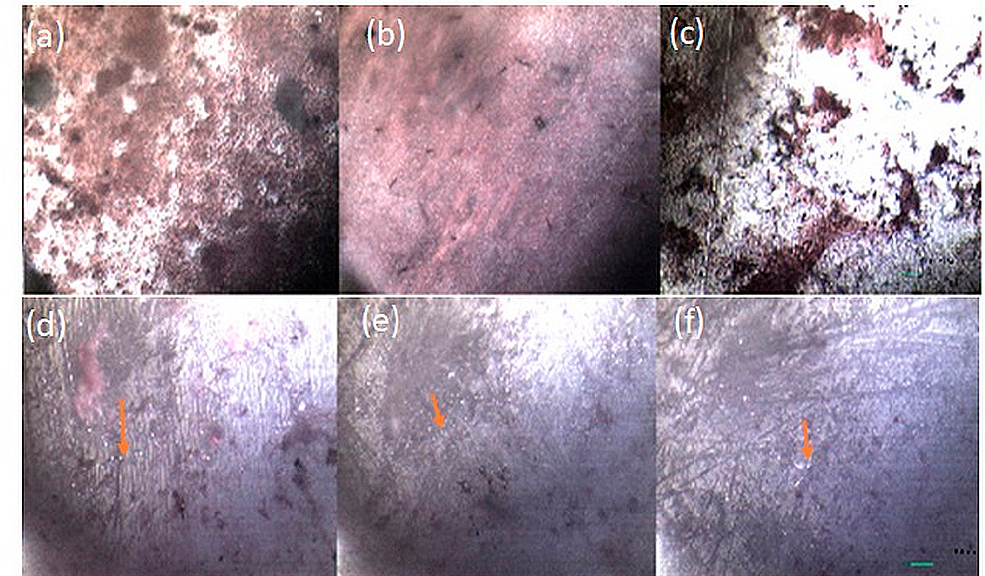
Figure 6. Optical microscopic images of Zn–HA discs at ( a ) 30 min, ( b ) 2 h and ( c ) 6 h and Zn–HA-coated samples at ( d ) 30 min, ( e ) 2 h and ( f ) 6 h of Mg–HA. Arrows indicate the presence of S. aureus on substrate surface. Scale bar ~150 µm.